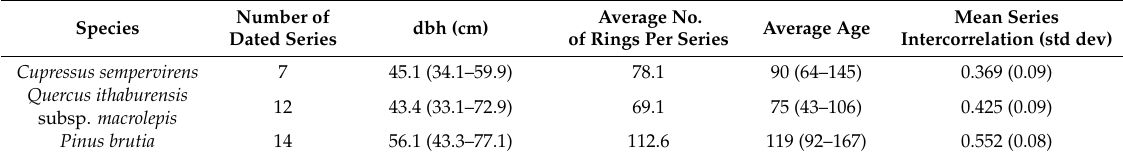
Table 4. Descriptive statistics of the chronologies developed per dominant tree species. The mean diameter at breast height (dbh) is reported together with the minimum and maximum values of the sampled trees. Standard deviation (std dev) is provided for the mean series intercorrelation.